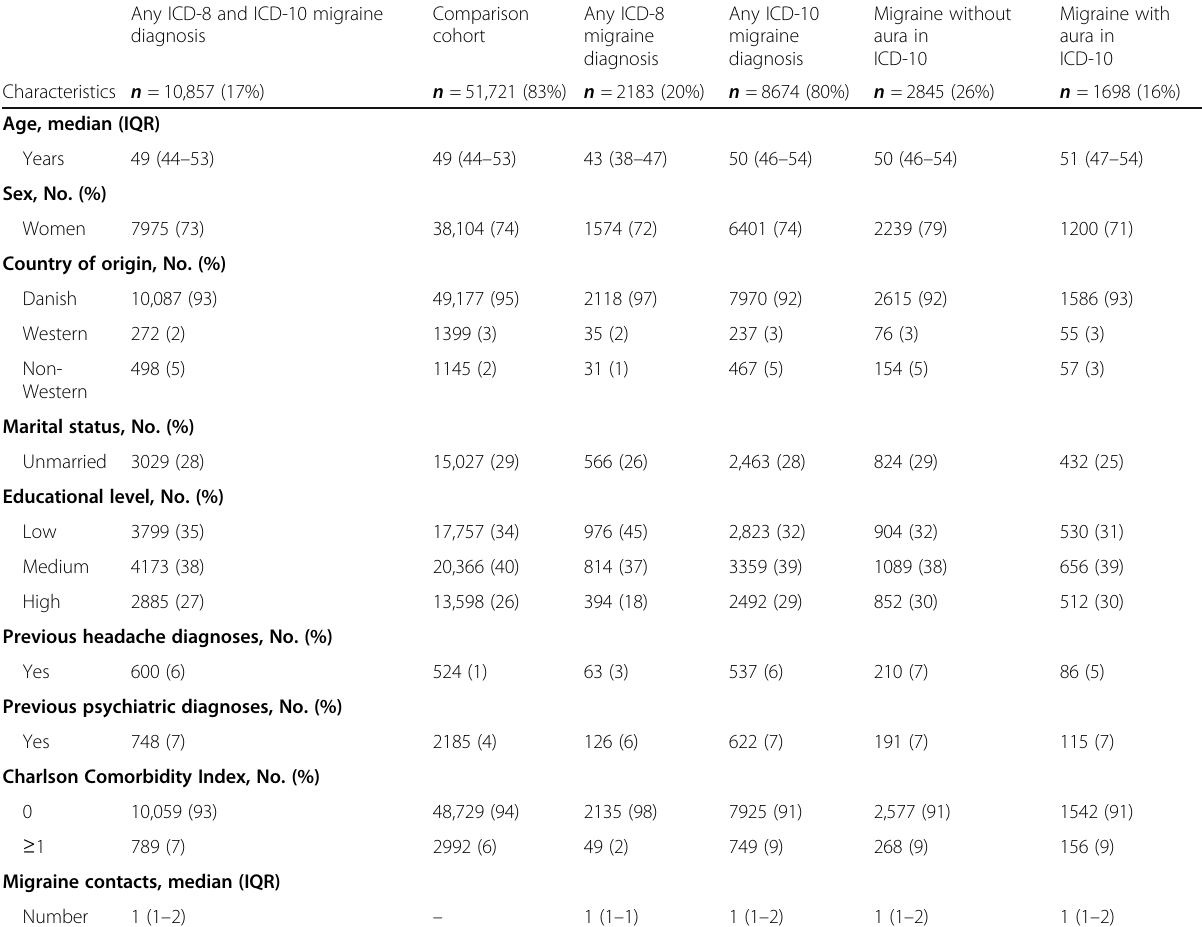
Table 2 Baseline characteristics of the study population based on migraine diagnoses shown in prevalence and medians ( N = 62,578) Any ICD-8 and ICD-10 migraine diagnosis